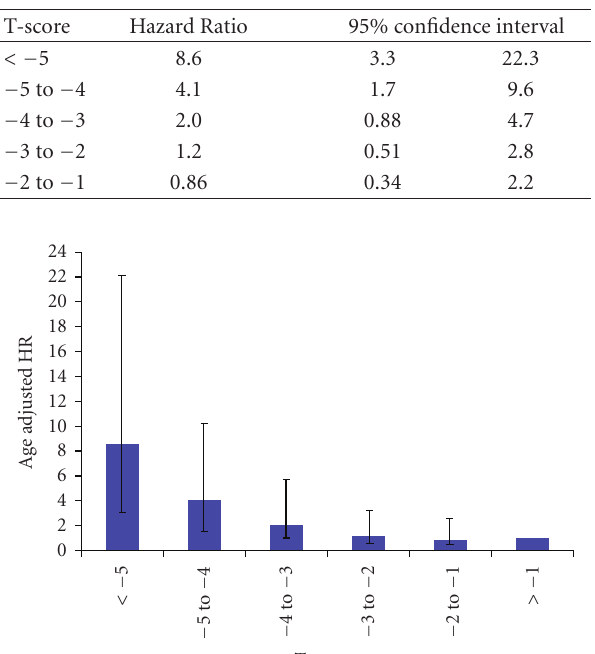
Table 3: The age-adjusted hazard ratio of hip fracture with di ff erent T-score categories compared against T-score > − 1.